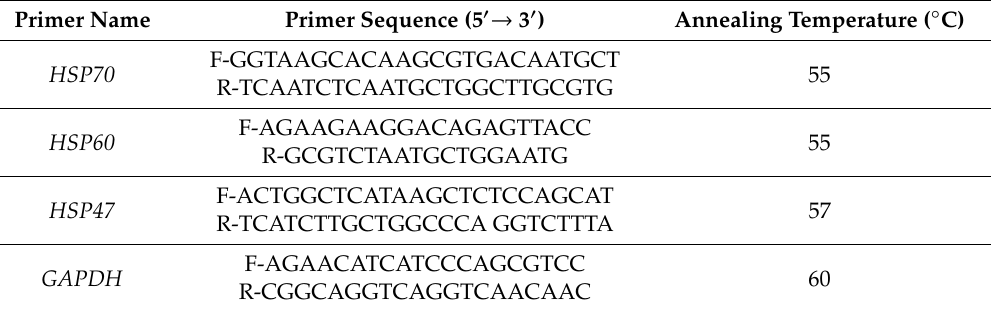
Table 1. Primers used for